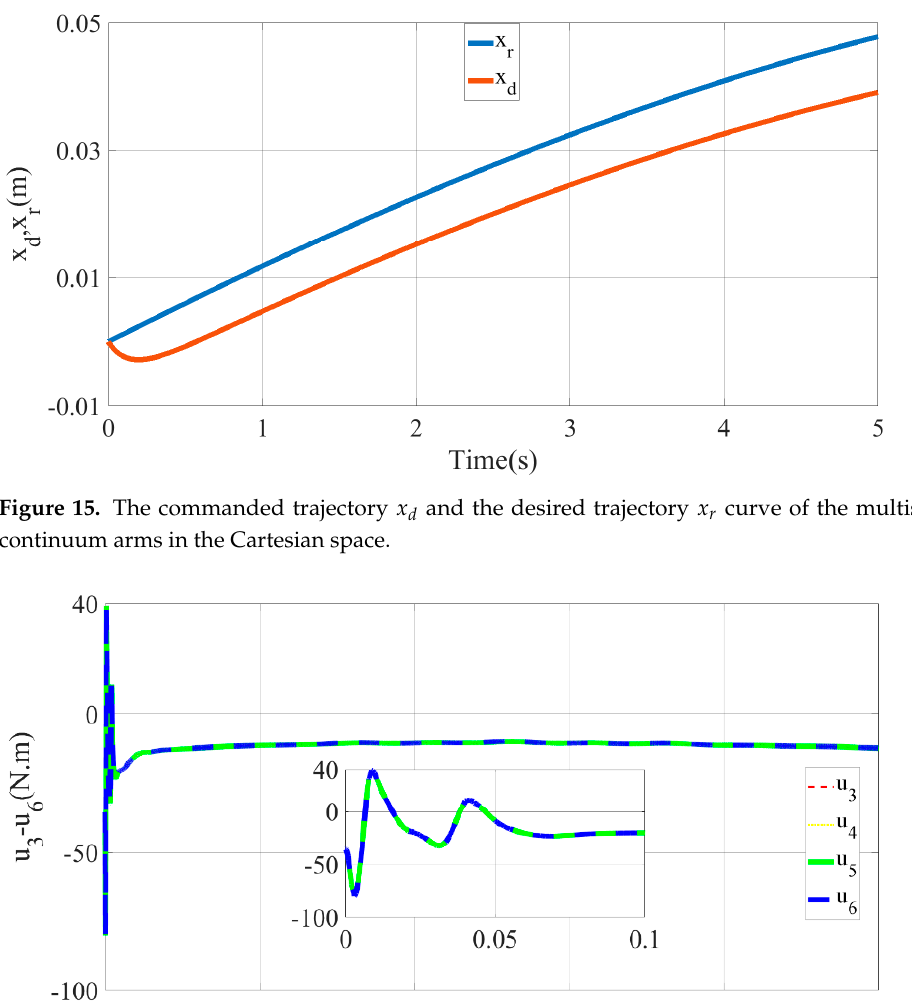
F and human ‐ machine interaction force id